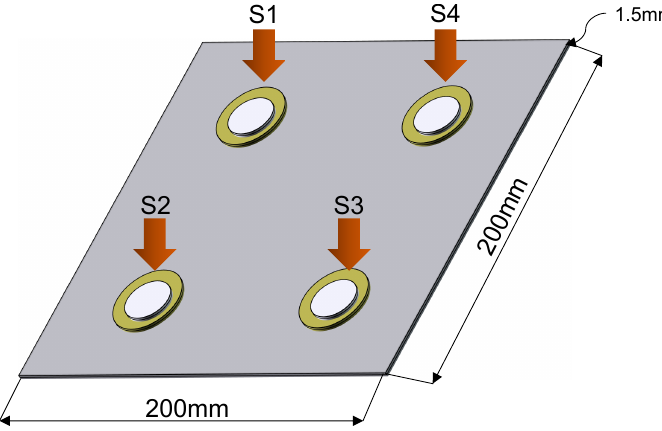
Figure 12. Graphic representation of the